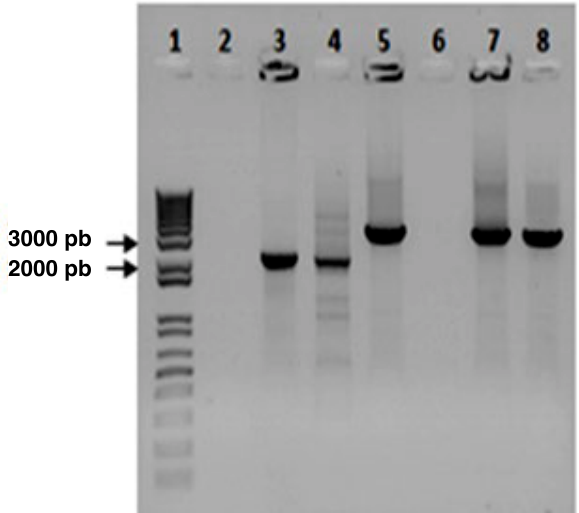
Figure 2. PCR analysis for the verification of the in - sert in Agrobacterium fabrum C58Gm r . Lanes 1 and 2 correspond,respectively, to the 1 kb+ marker and negative control (DSW). The DNA band in lane 3 corresponds to PCR product when using primers F9550-F9551 on DNAg of A. fabrum . DNA bands in lanes 5, 7 and 8 correspond, respectively, to successful insertion in A. fabrum recovered from YPG agar after the double recombination when using primers F9550-F9551 and F9550-F9547 and F9544-F9551. Lanes 4 and 6 correspond, respectively, to a failed inser- tion in A. fabrum C58 recovered from YPG agar when using primers F9550-F9551 and F9550-F9547.